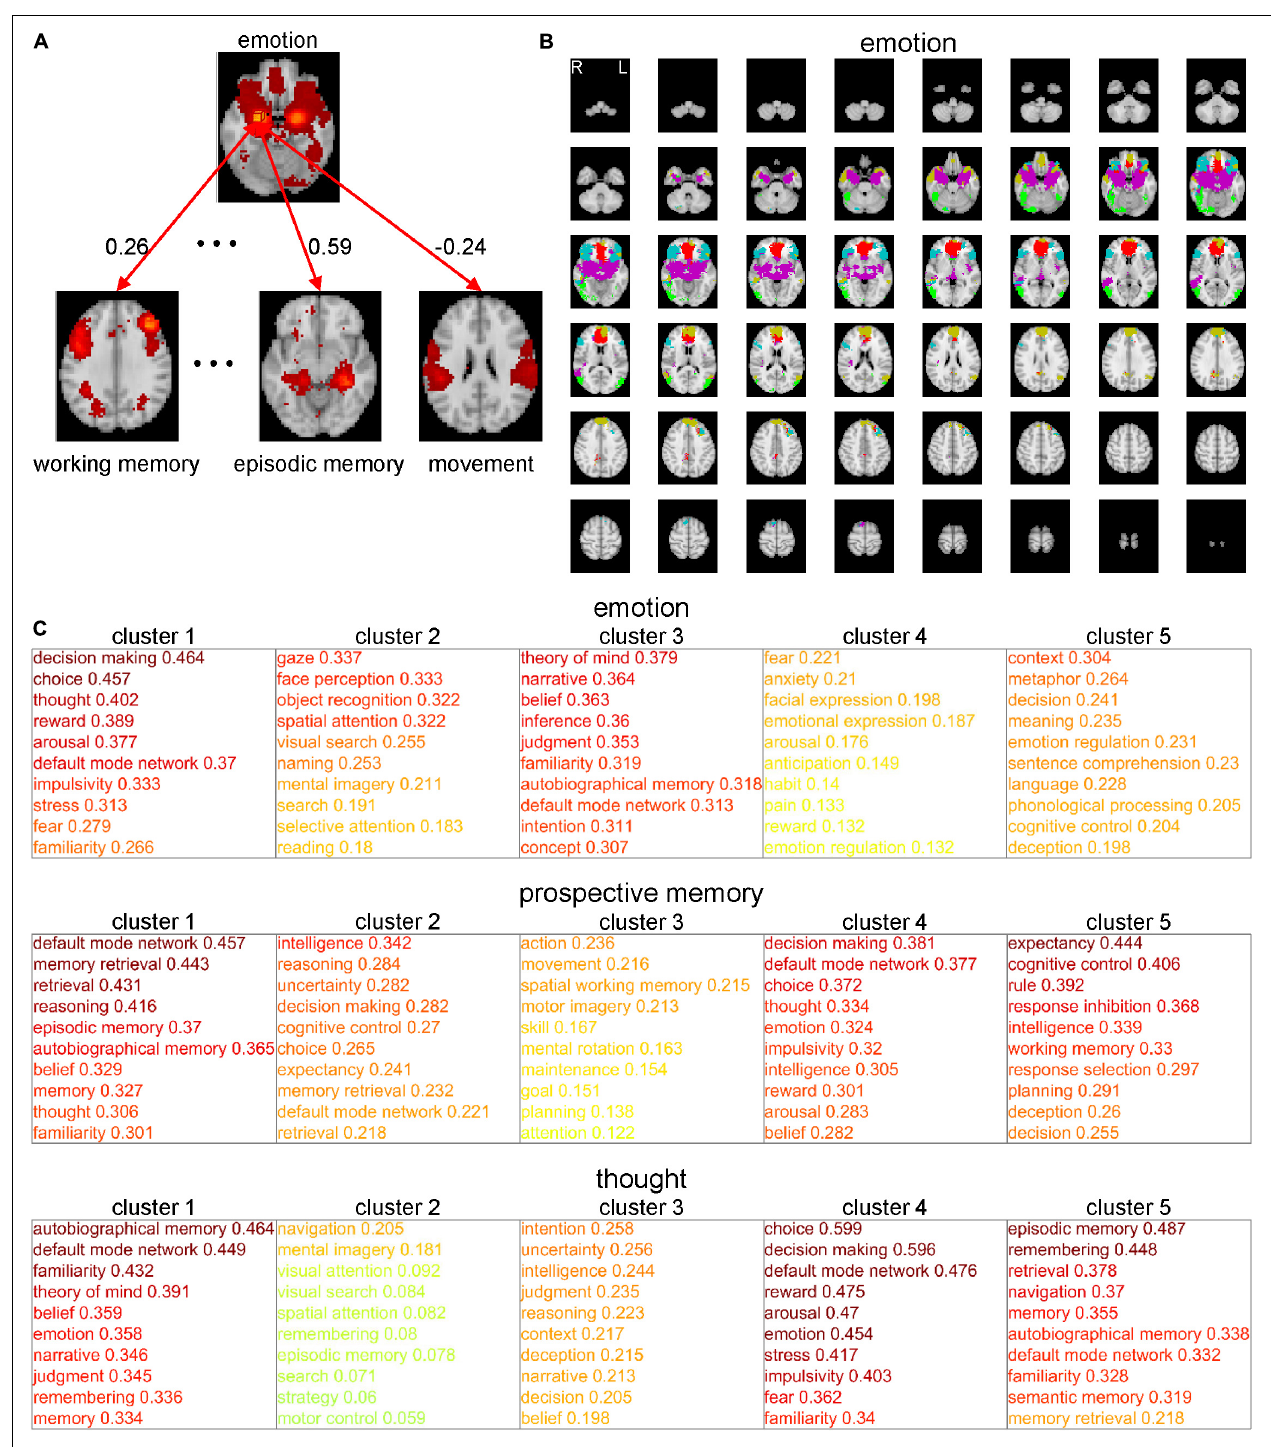
FIGURE 2 | Conceptual analysis of cognitive functions based on subdivisions of the cognitive function maps (CFMs). (A) Schematic illustration of voxel-to-CFM resting-state functional connectivities (RSFCs) between voxels in a CFM of cognitive function under consideration (e.g., ‘emotion’) and the other CFMs. (B) Example of subdivision of the CFM of ‘emotion’ obtained by applying k-means clustering to the CFM. In this analysis, the number of clusters was fixed to five. Each color corresponds to each cluster resulting from the subdivision. (C) Examples of subdivision-based conceptual analyses for ‘emotion’ (upper), ‘prospective memory’ (middle), and ‘thought’ (lower). The cluster-to-CFM RSFCs are shown with the names of corresponding cognitive functions. For each cluster, the cluster-to-CFM RSFCs are defined as the mean values of the voxel-to-CFM RSFCs for the voxels belonging to the cluster.